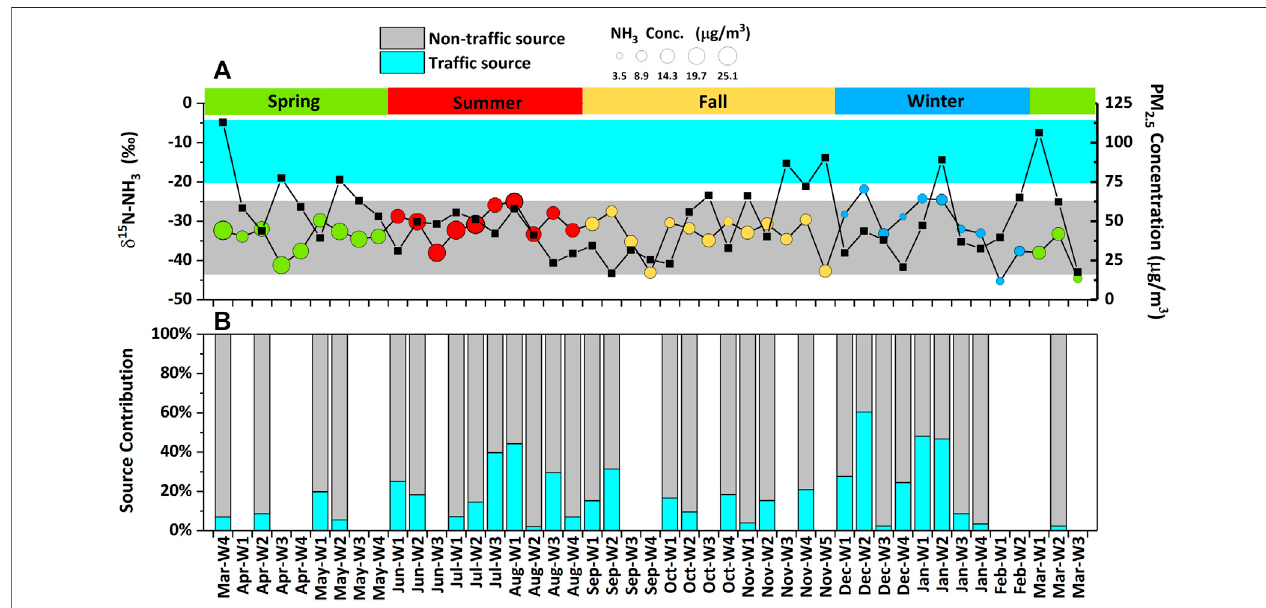
FIGURE 5 | The contribution proportion of traf fi c source and non-traf fi c sources to ambient NH 3 . (A) shows the δ 15 N-NH 3 value, NH 3 concentration, and PM 2.5 concentration. (B) shows the contribution of traf fi c source and non-traf fi c sources to ambient NH 3 .